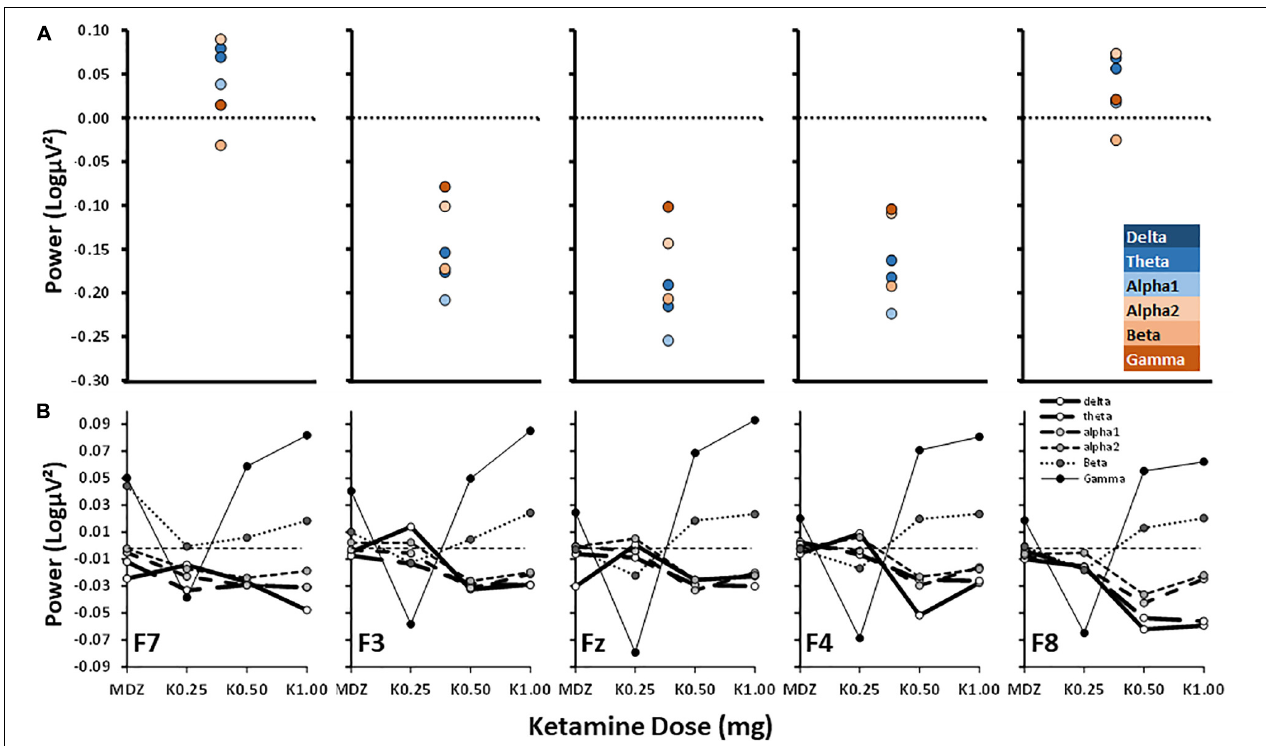
FIGURE 2 | Power difference scores for control–patient and post–pre ketamine across bands and frontal channels. (A) Control–patient power is as in Figure 1C but with the direction of subtraction reversed and graphs plotted to match the published results shown below in (B) . (B) Post–pre dose effect of ketamine from Shadli et al. (2018) with permission of the authors. MDZ = midazolam (active control); K0.25, etc., doses of ketamine in mg. Note power scale differences.